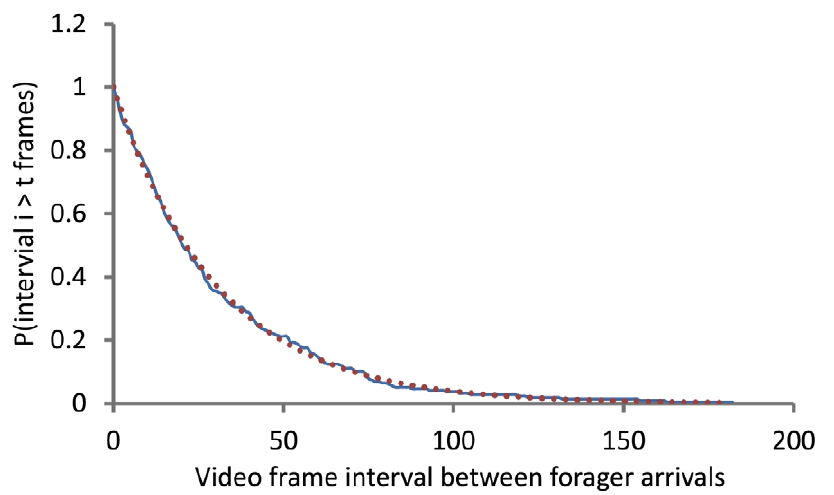
Figure 1. Poisson distribution of intervals between the arrival of successive returning foragers at the nest. The figure shows representative data from one trial in which returning foragers were removed. Intervals are shown in video frames; each frame is 1/30 sec. The y-axis is the probability that the interval i between successive returning foragers exceeds t frames. The solid blue line corresponds to the real data and the dotted red line corresponds to the exponential fit y= e 2 0.0326 t with a mean separation time of 1/0.0326 or 30.67 frames, equal to 1.02 seconds.